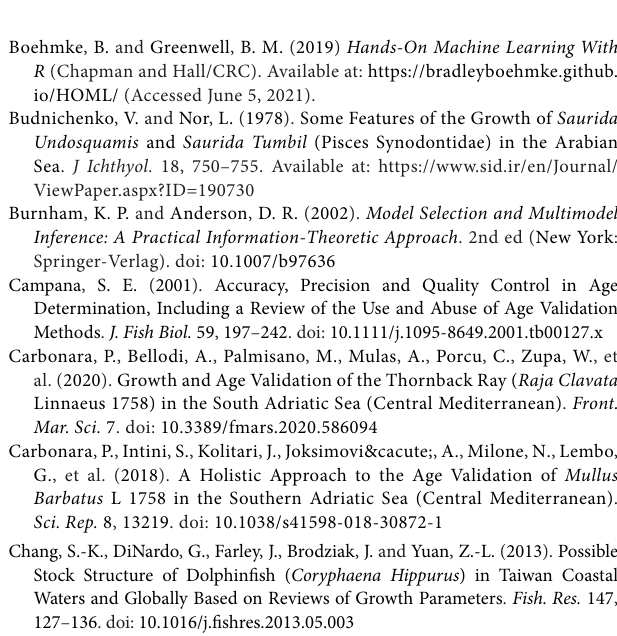
Supplementary Figure 1 | Sample image of transverse and sagittal sections of otolith. Supplementary Figure 2 | Scree plot (within-clusters sum of squares) of the hierarchical clustering analysis. Supplementary Figure 3 | Variable importance plot using the mean decrease in Gini coefficient. Supplementary Table 1 | Global estimates of growth parameters of brushtooth lizardfish from the literature. Lengths are in the unit of cm, K in year-1, and t o